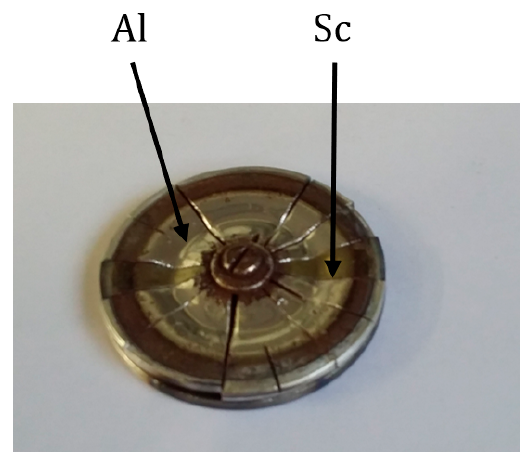
Figure 1. Picture of the sputtering target.